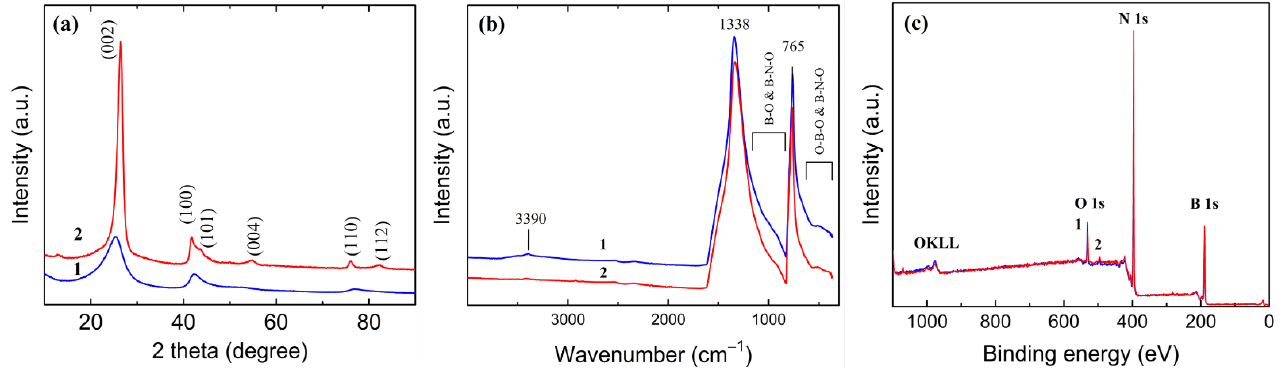
Figure 7. XRD patterns (Cu- Kα radiation) ( a ), FTIR ( b ), and XPS ( c ) spectra of the BNO 1 (1) and BNO 2 (2) nanopowders.